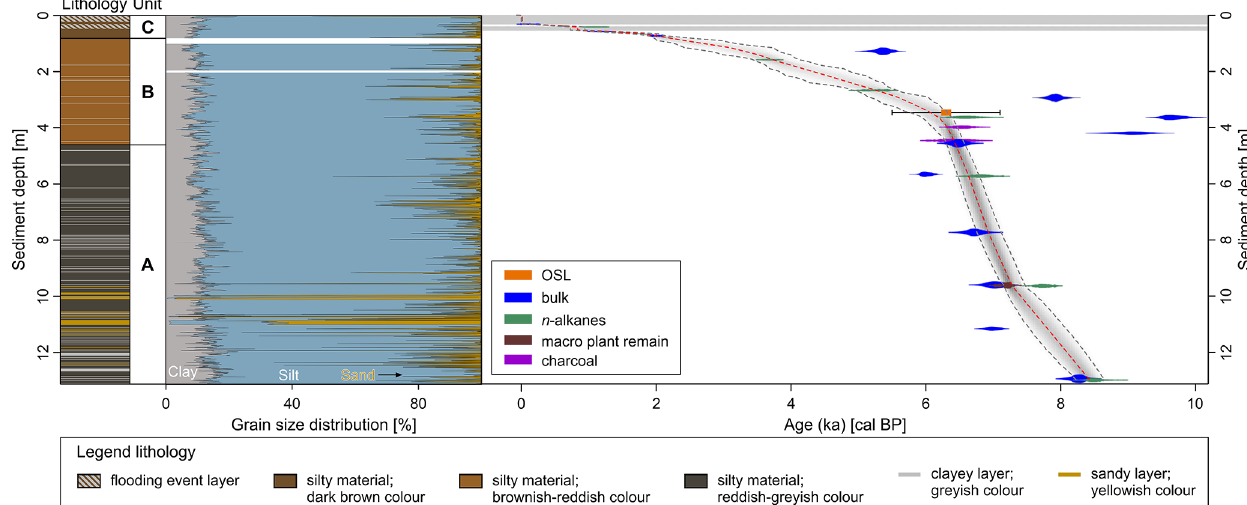
Figure 2. Left: lithology and grain size distribution (clay, silt, sand) of the VOV16 record from Voëlvlei. Right: age–depth model of the sediment record from Voëlvlei. Calibrated radiocarbon ages are displayed as probability density functions of the 2 σ distributions (blue: bulk sediment; green: compound-class n-alkane samples; brown: macro plant remain). Calibration and age–depth modelling was carried out using the R software package Bacon 2.4.3 (Blaauw and Christen, 2011).